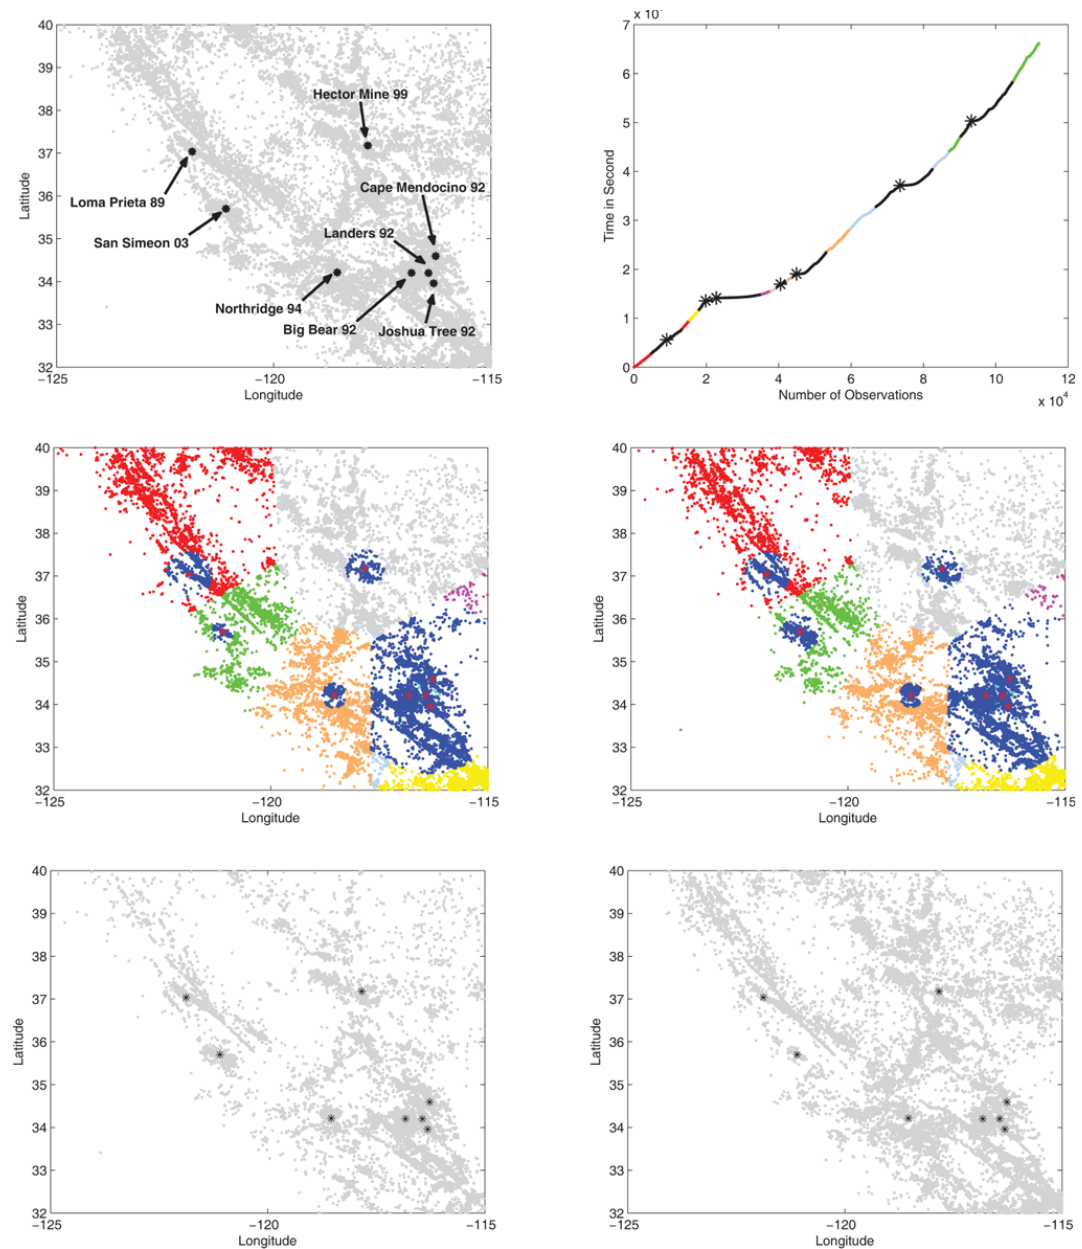
Fig. 8. Tri-stage cluster identification of the seismic catalog of California: (top left) location of mainshocks during year 1988–2008; (top right) output of time zone clustering; (middle left) output of background and clustered coordinate zone for C 1; (middle right) output of background and clustered coordinate zone for C 2; (bottom left) events classified as aftershocks; (bottom right) events classified as